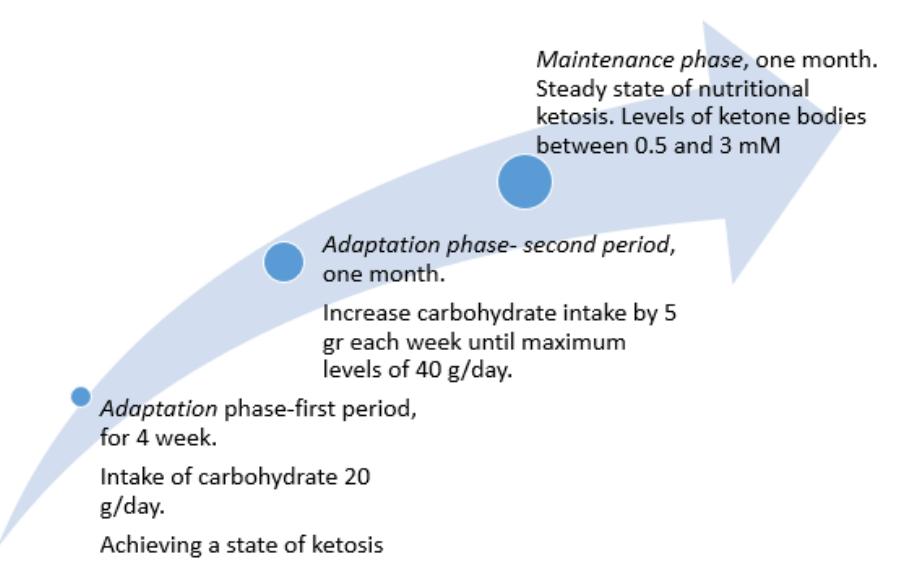
Figure 1. Trend of daily carbohydrate intake in the protocol to be developed to achieve proper levels of ketosi s .